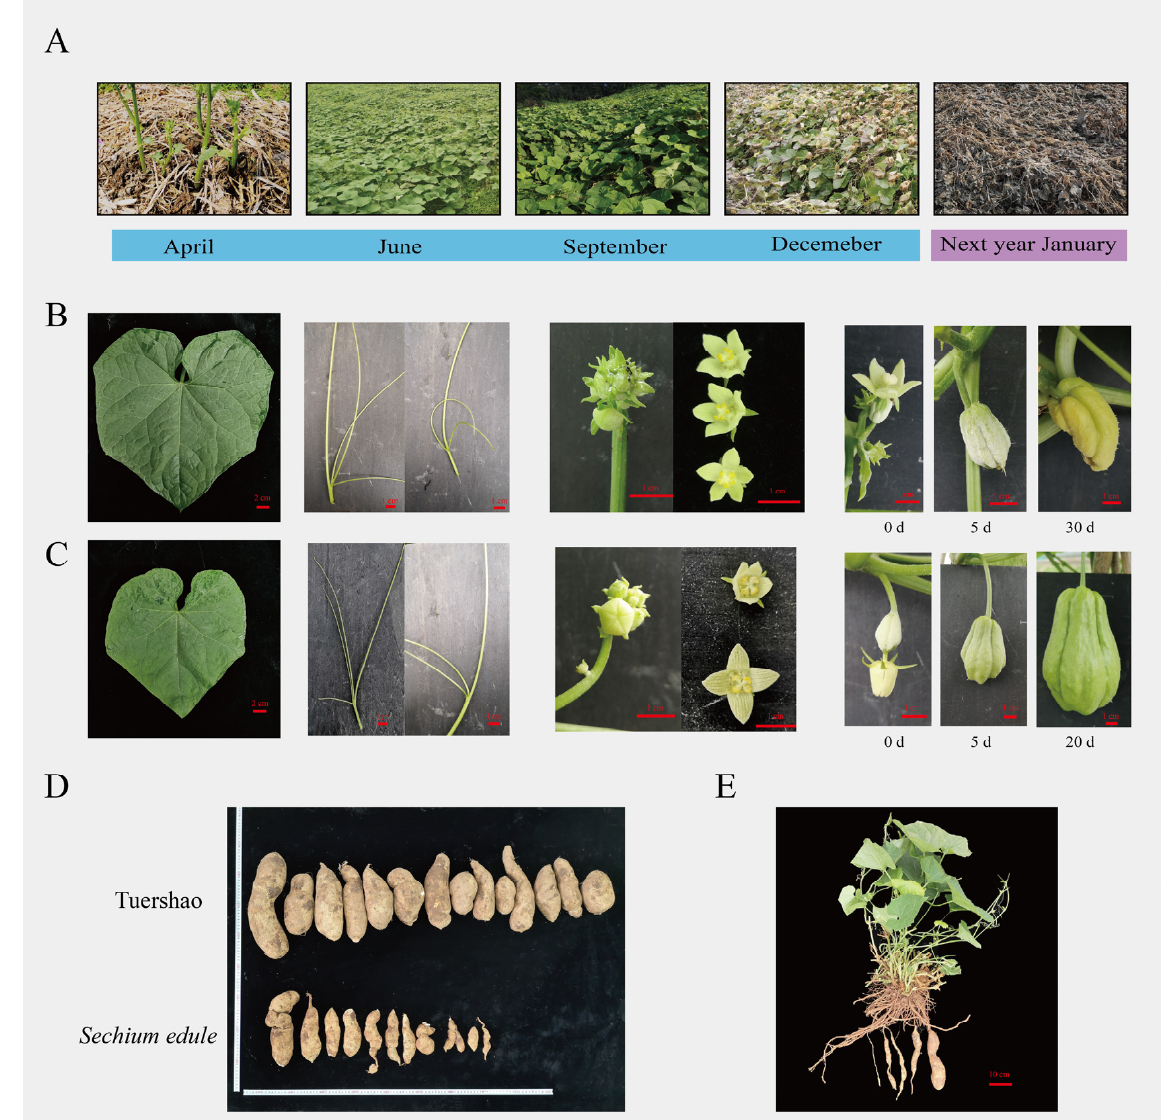
Figure 1. Morphological characteristics of ‘Tuershao’ and S. edule . ‘Tuershao’ plant growth in one growing season ( A ). Morphological characteristics of ‘Tuershao’ ( B ) and S. edule ( C ). Tuber yield after one year of growth of ‘Tuershao’ and four-year-old S. edule plants ( D ). ‘Tuershao’ plant ( E ).